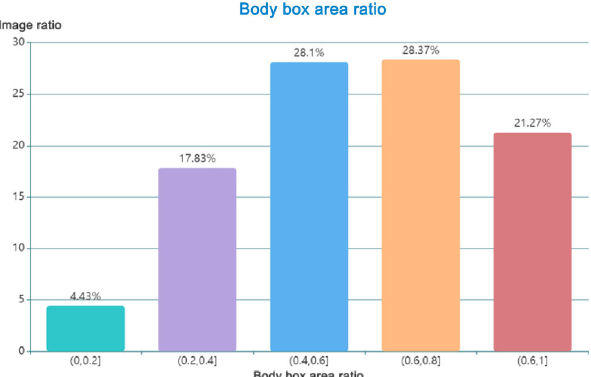
Fig. 10 Fraction of the image covered by the dog’s body bounding box.